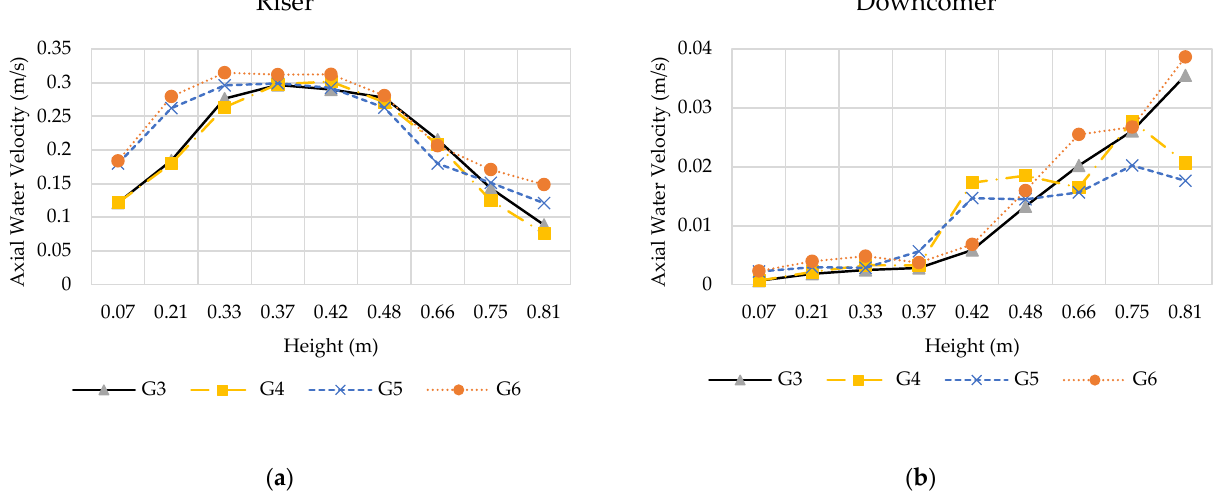
Figure 8. ( a ) Axial velocity in riser of geometries 3, 4, 5 and 6 based on 9 sampling points; ( b ) Axial velocity in riser of geometries 3, 4, 5 and 6 based on 9 sampling points.